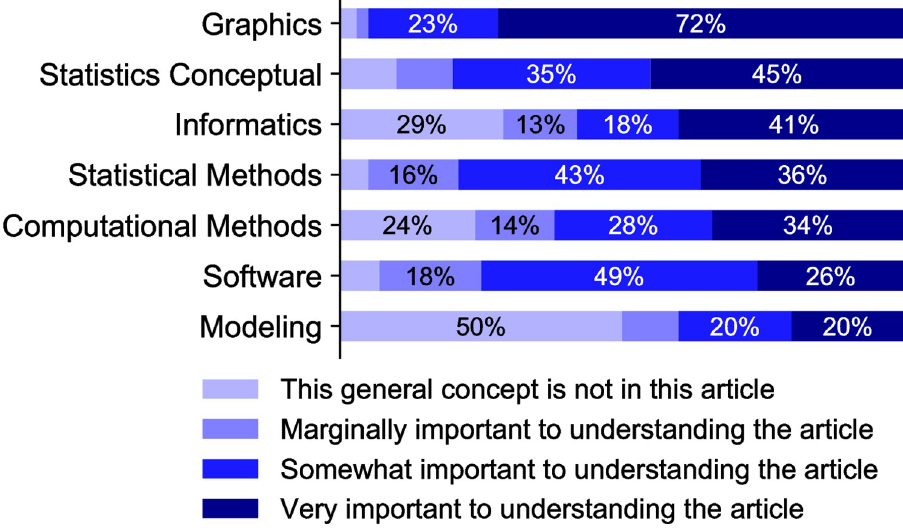
Fig 2. General concepts. The seven general concepts identified in the submitted papers and the proportions of importance level of each concept. Percentage values indicate the percent of papers in which a given concept was assigned a given importance level. Values greater than 10% are labeled with